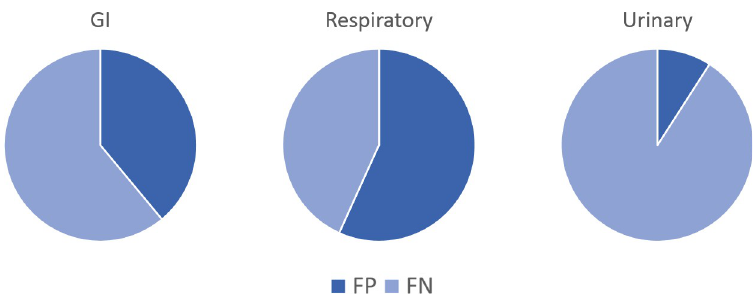
Fig 8. Error rates of the random forest model. Percentages of error due to false negatives and false positives.